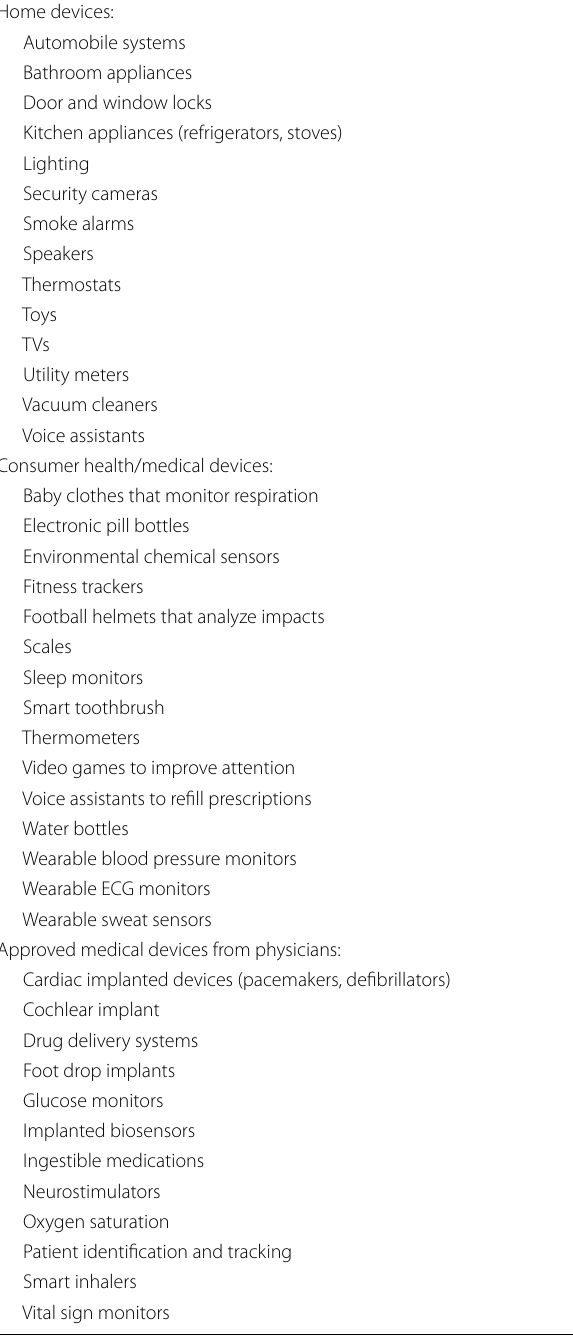
Table 1 Examples of IoT